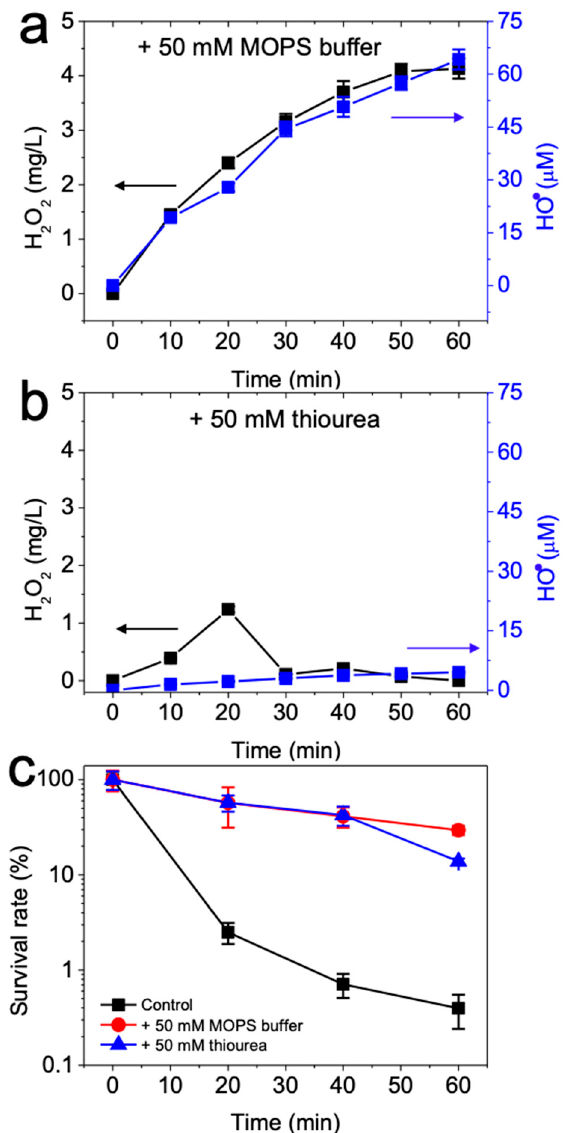
Figure 3. Yields of hydrogen peroxide and hydroxyl radical during electro-Fenton process after addition of ( a ) 50 mM MOPS buffer or ( b ) 50 mM thiourea and ( c ) performance of bacterial disinfection performance. Conditions: 3 g GAC as cathode under 100 mA current, 0.2 mM FeSO 4 , 10 8 CFU/mL E. coli , pH ini 7. Control indicates electro-Fenton process.